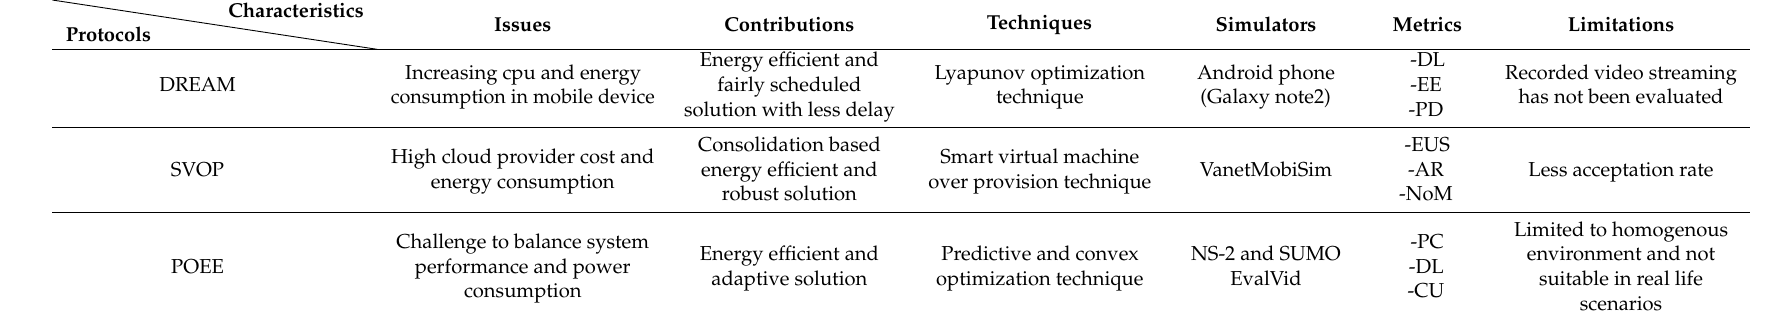
Table 14. Summary of energy efficient cloud computing techniques.